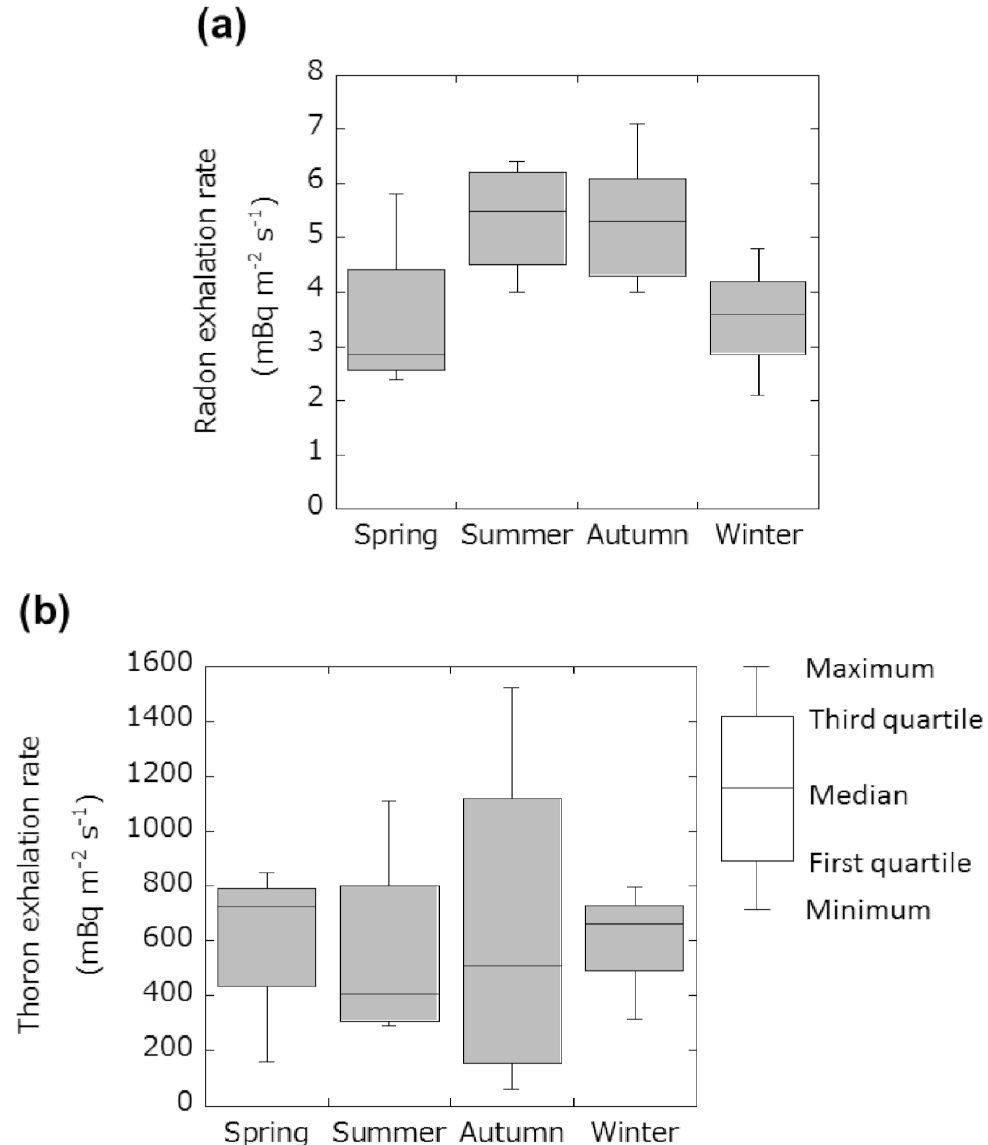
Figure 3. Seasonal variations of radon ( a ) and thoron ( b ) exhalation rates. The lines from top to bottom of the box-plot from top to bottom are defined as maximum, third quartile (75th percentile), median (50th percentile), first quartile (25th percentile), and minimum